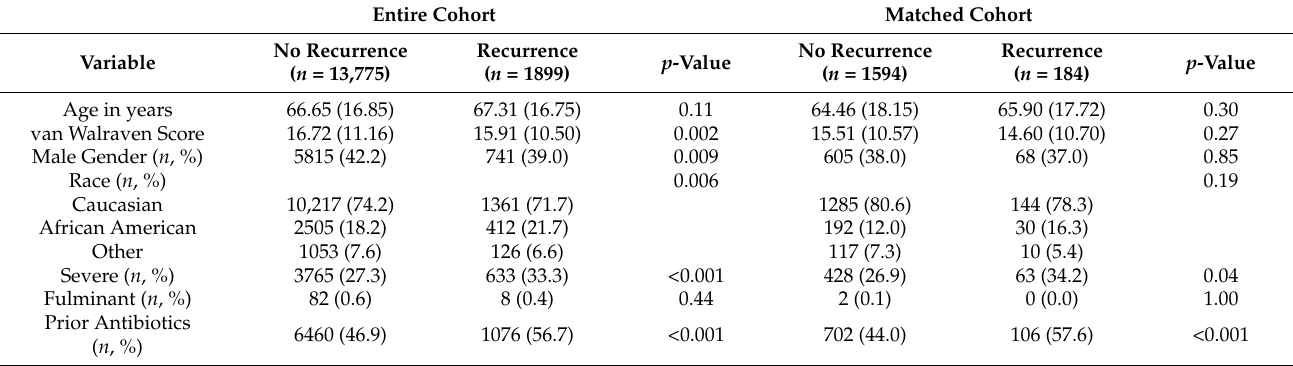
Table 2. Characteristics by recurrence status (mean, standard devation unless otherwise noted).